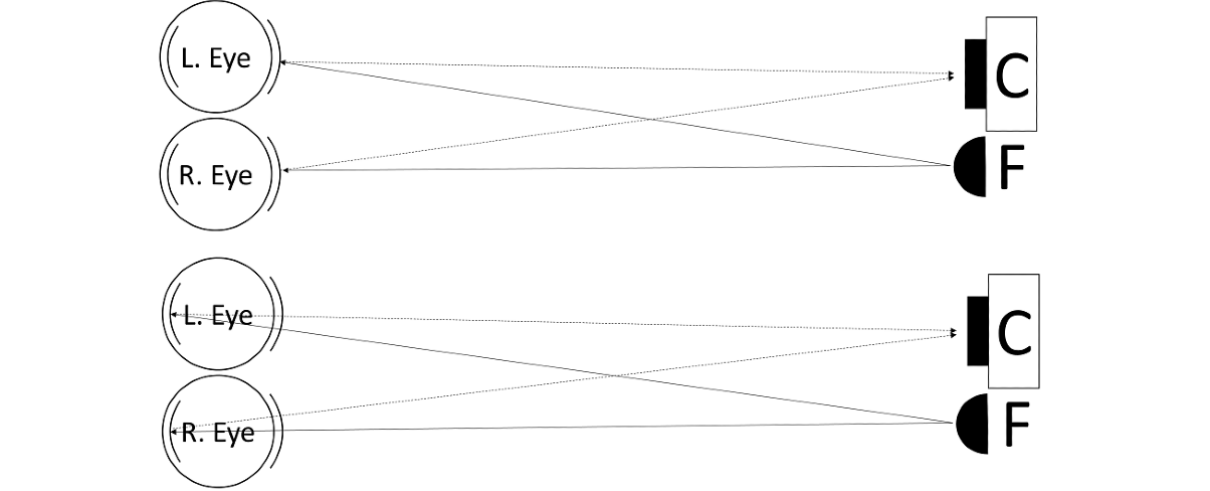
Figure 2. Simplified optical models. Top: Corneal luminous reflection. Bottom: Red reflex. C: camera; F: flash; L: left; R: